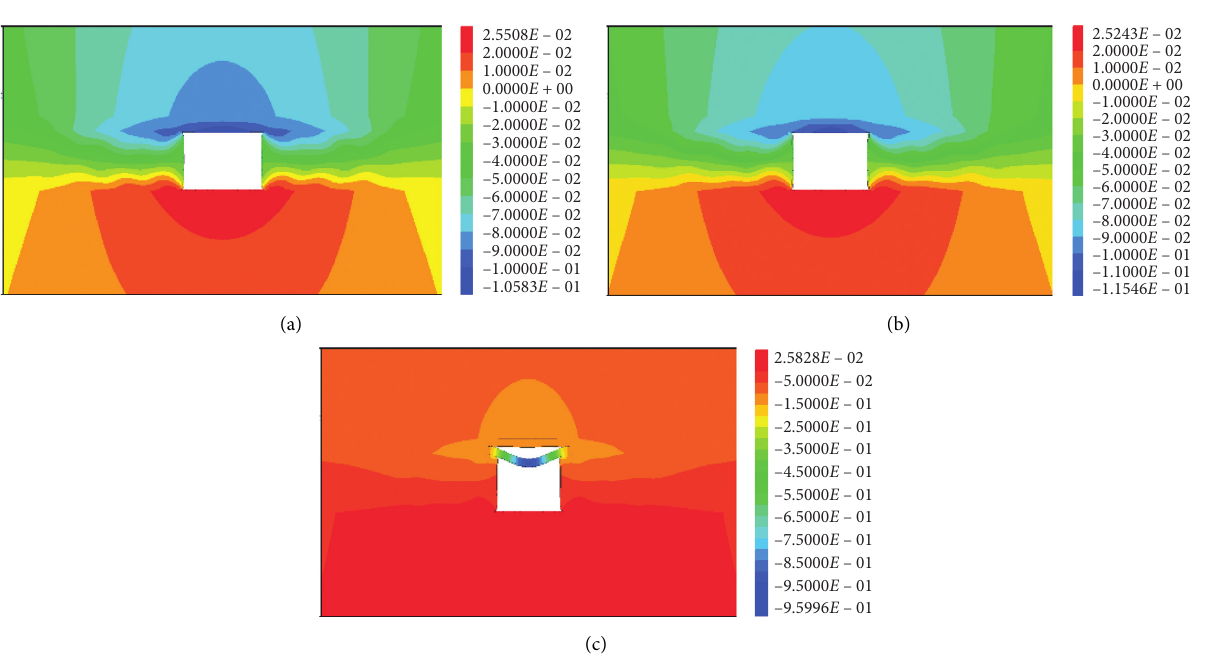
Figure 5: Roof sag of different horizontal stresses: (a) 20MPa, (b) 30MPa, and (c)